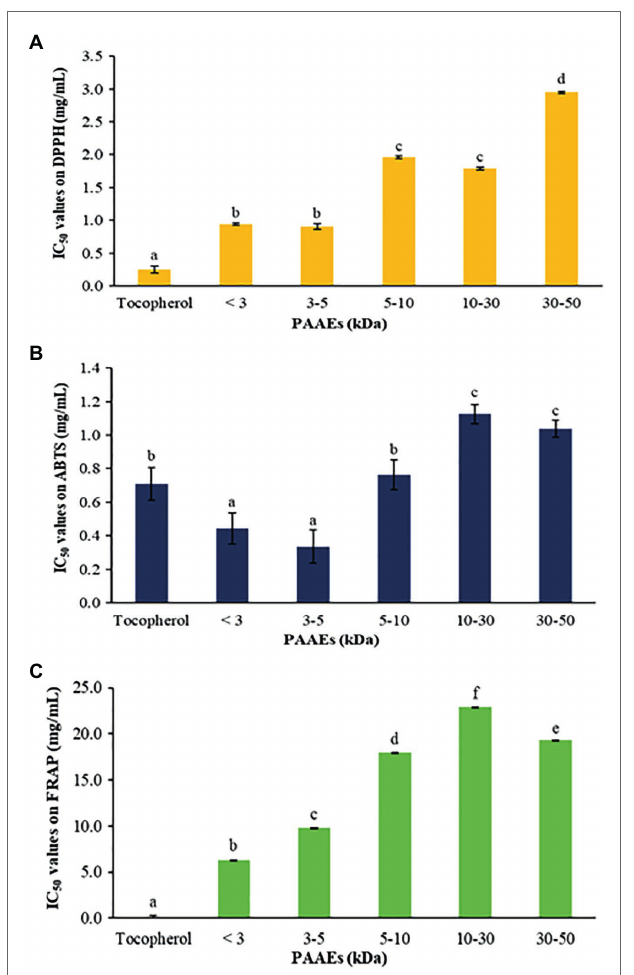
FIGURE 9 | The PAAEs activities against DPPH radical scavenging activity (A) , ABTS radical scavenging activity (B) , and ferric reducing antioxidant powder (C) . The results were expressed as mean with SD of three replications. a–f The values with different letters show significant differences ( p < 0.05).